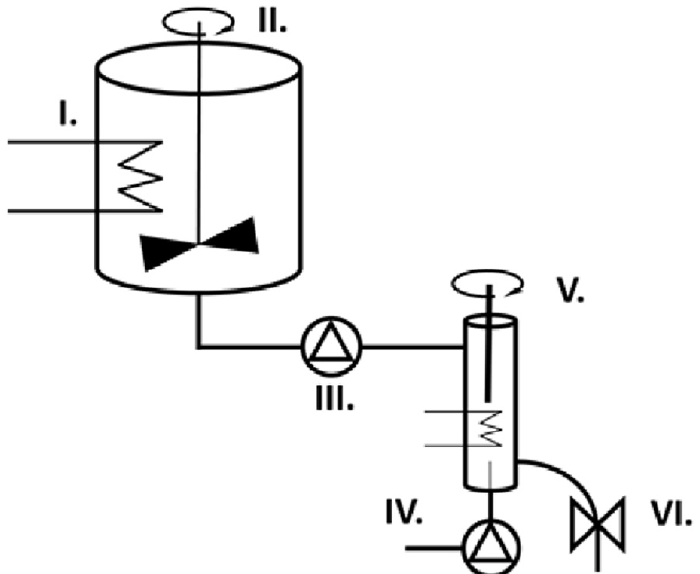
Figure 1. The foaming device contains six main parts. The heated melting vessel (I) and IKA EURO-ST D stirrer (II) are responsible for the homogenous molten suspension that is transferred to the heated foaming cell (IV) by a peristaltic pump (III). The added gas is dispersed by the ULTRA-TURRAX (V) in the melt and dosed by a pinch valve